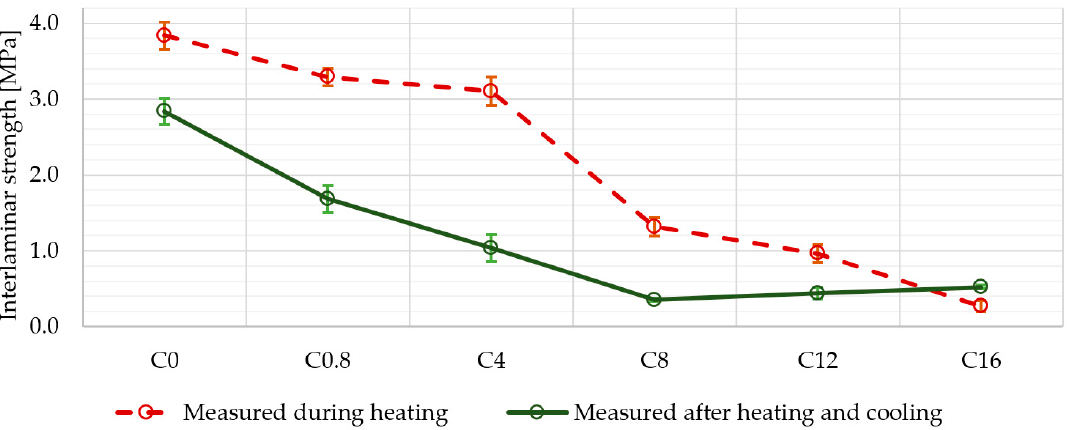
Figure 8. Comparison of interlaminar strength results of samples measured during and after heat treatment.